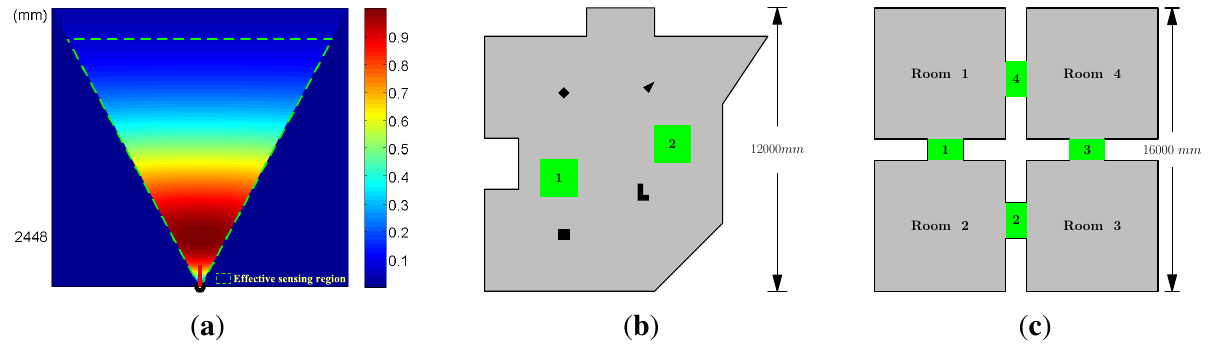
Figure 1. Experimental Parameters. (a) Distribution of observation quality in the sensing field of a selected camera. (b)(c) Two experimental scenes: dark blocks denote the obstacles; green blocks denote the critical regions, which need more observation resources.